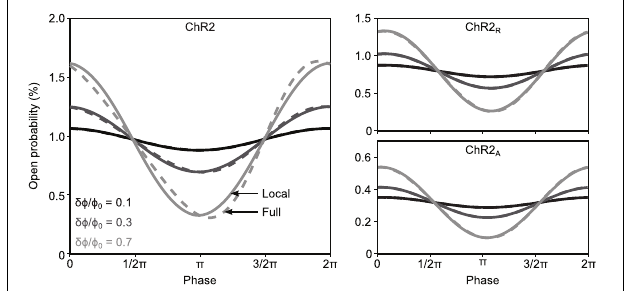
FIGURE 2 | F ChR2 ( ω ) ’s linear time-invariant response versus complete model dynamics for different ChR2 variants. The time-invariant F ChR2 ( ω ) approximation (solid lines) and the complete dynamics (dashed lines) of O ( t ) are shown in response to 5Hz sinusoidal stimuli for ChR2 (left), ChR2 R (right, top) and ChR2 A (right, bottom). Gray shades represent different sinusoidal amplitudes normalized to the mean stimulus intensity, δφ / φ 0 = 0 . 1 , 0 . 3 , and 0 .